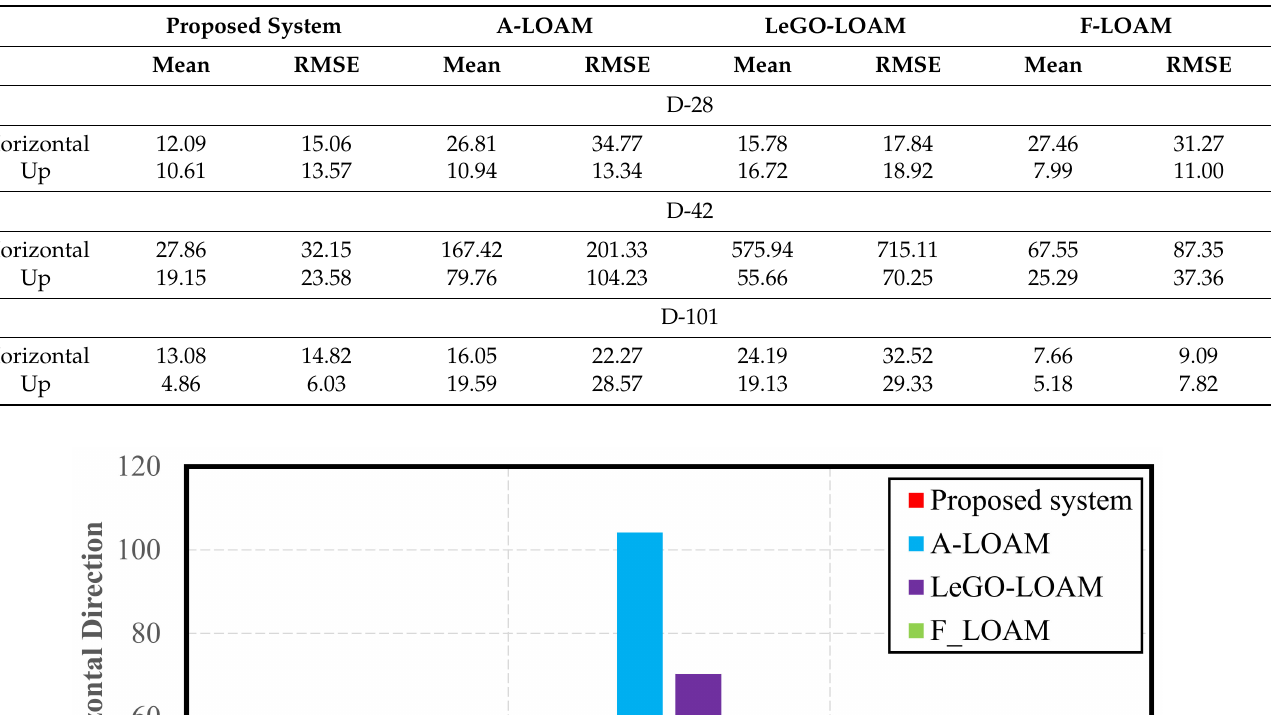
Table 8. D-42—GNSS-assisted—position (m) and attitude (deg) error statistics.